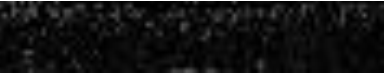
Figure 19. An example of the processed image formed in the first step.